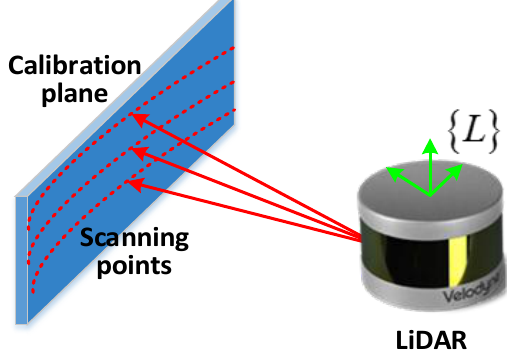
Figure 2. The LIDAR position and point feature detection.